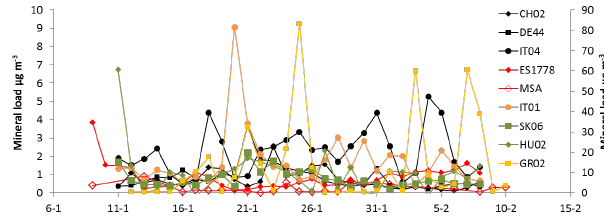
Figure 9. Time series of mineral dust concentrations during the Jan- uary/February 2013 EMEP IMP at selected sites affected by the Sa- haran dust outbreaks. Levels of mineral dust at GR02 (right axis) reflect the impact of short but intense dust